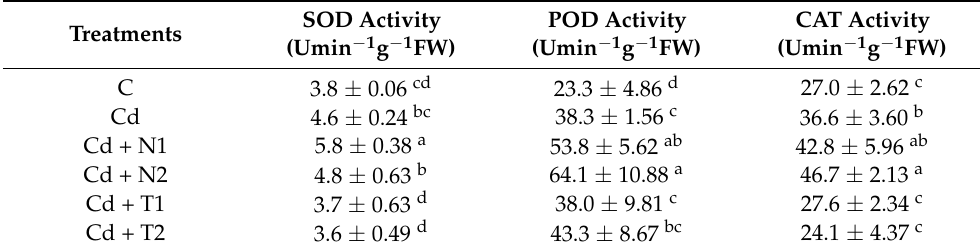
Table 3. Antioxidant enzyme activities of tomato plants under Cd stress. SOD Activity Treatments (Umin − 1 g − 1 FW)